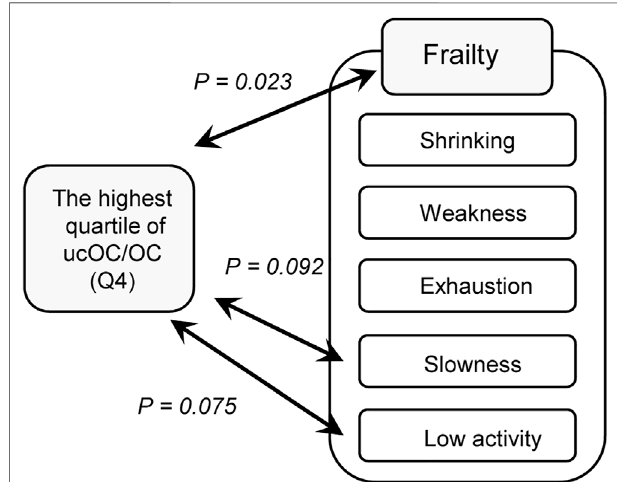
FIGURE 1 | Association of vitamin K insuf fi ciency and frailty. A diagram representing the results of the present study is shown. Vitamin K insuf fi ciency was evaluated by the ratio of undercarboxylated osteocalcin and osteocalcin (ucOC/OC) The highest quartile of ucOC/OC, which re fl ects relatively weak vitamin K function in vivo, was signi fi cantly associated with frailty as determined by the Japanese version of the Cardiovascular Health Study criteria ( p = 0.029), as shown in Table 2 . Among the components of frailty in the criteria, the highest quartile of ucOC/OC tended to be associated with “ slowness ” ( p = 0.092) and “ low activity ” ( p = 0.075), as shown in Table 3 .